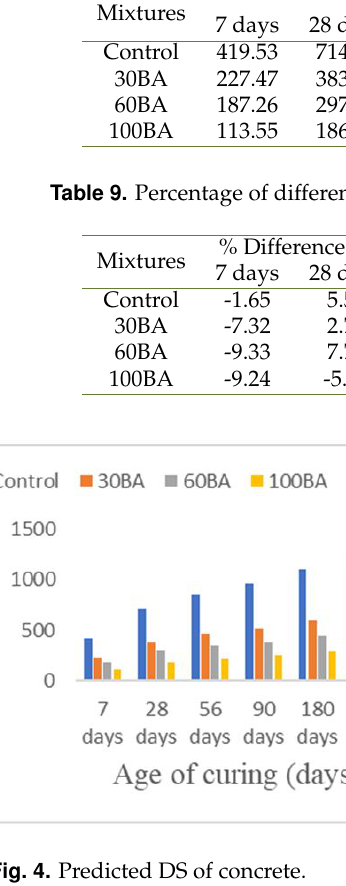
Fig. 4. Predicted DS of concrete.